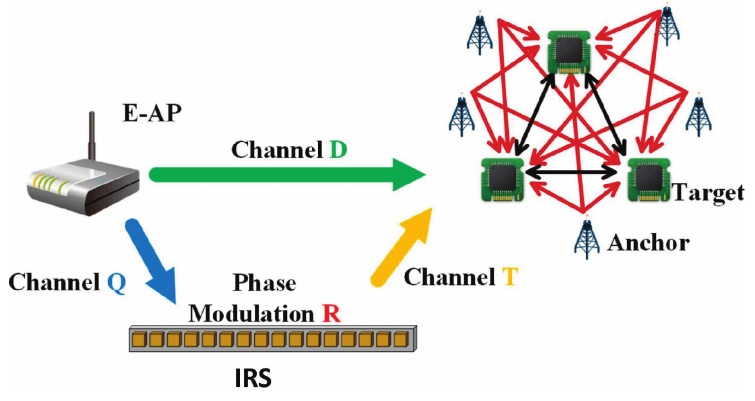
Figure 1. PWSN with